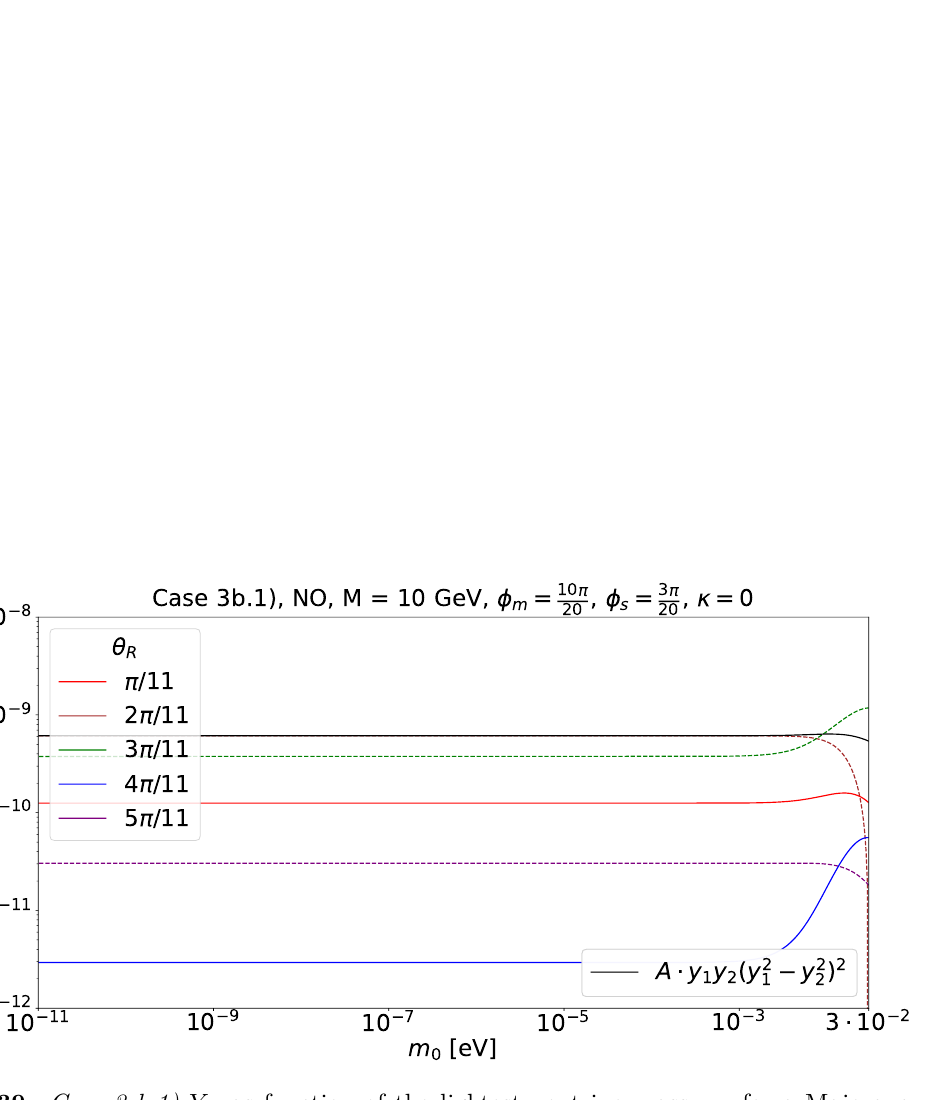
= 2 π , we R 11 ( y 2 ) − y 2 1 y 2 1 2 , on the couplings y , compare eq. (6.50). Both negative DEG ,α f